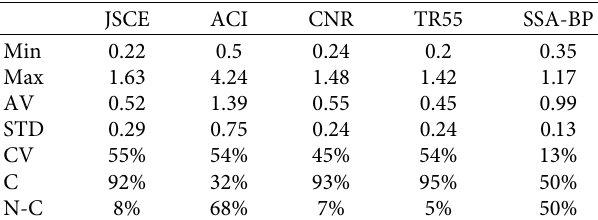
Figure 11: Predicted values and experimental values: (a) ACI, (b) JSCE, (c) TR55, (d) CNR, and (e) SSA-BP. Table 4: Statistical results of each